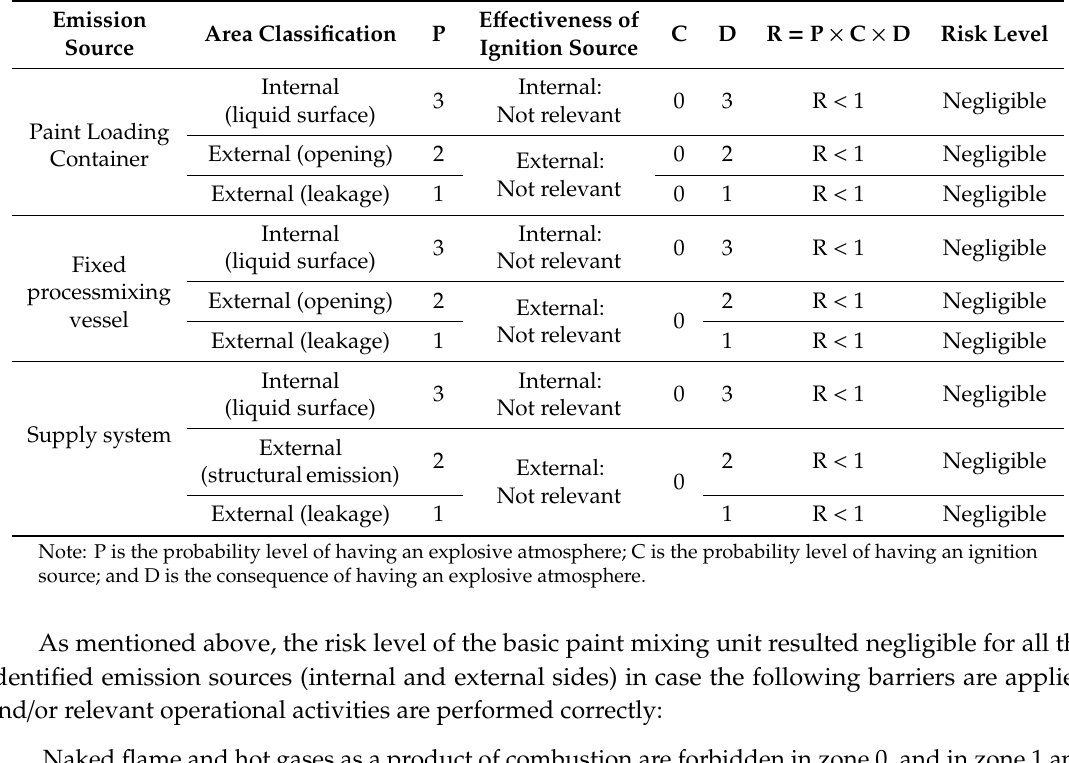
Table 15. Traditional ATEX Risk evaluation result for the basic paint mixing unit.